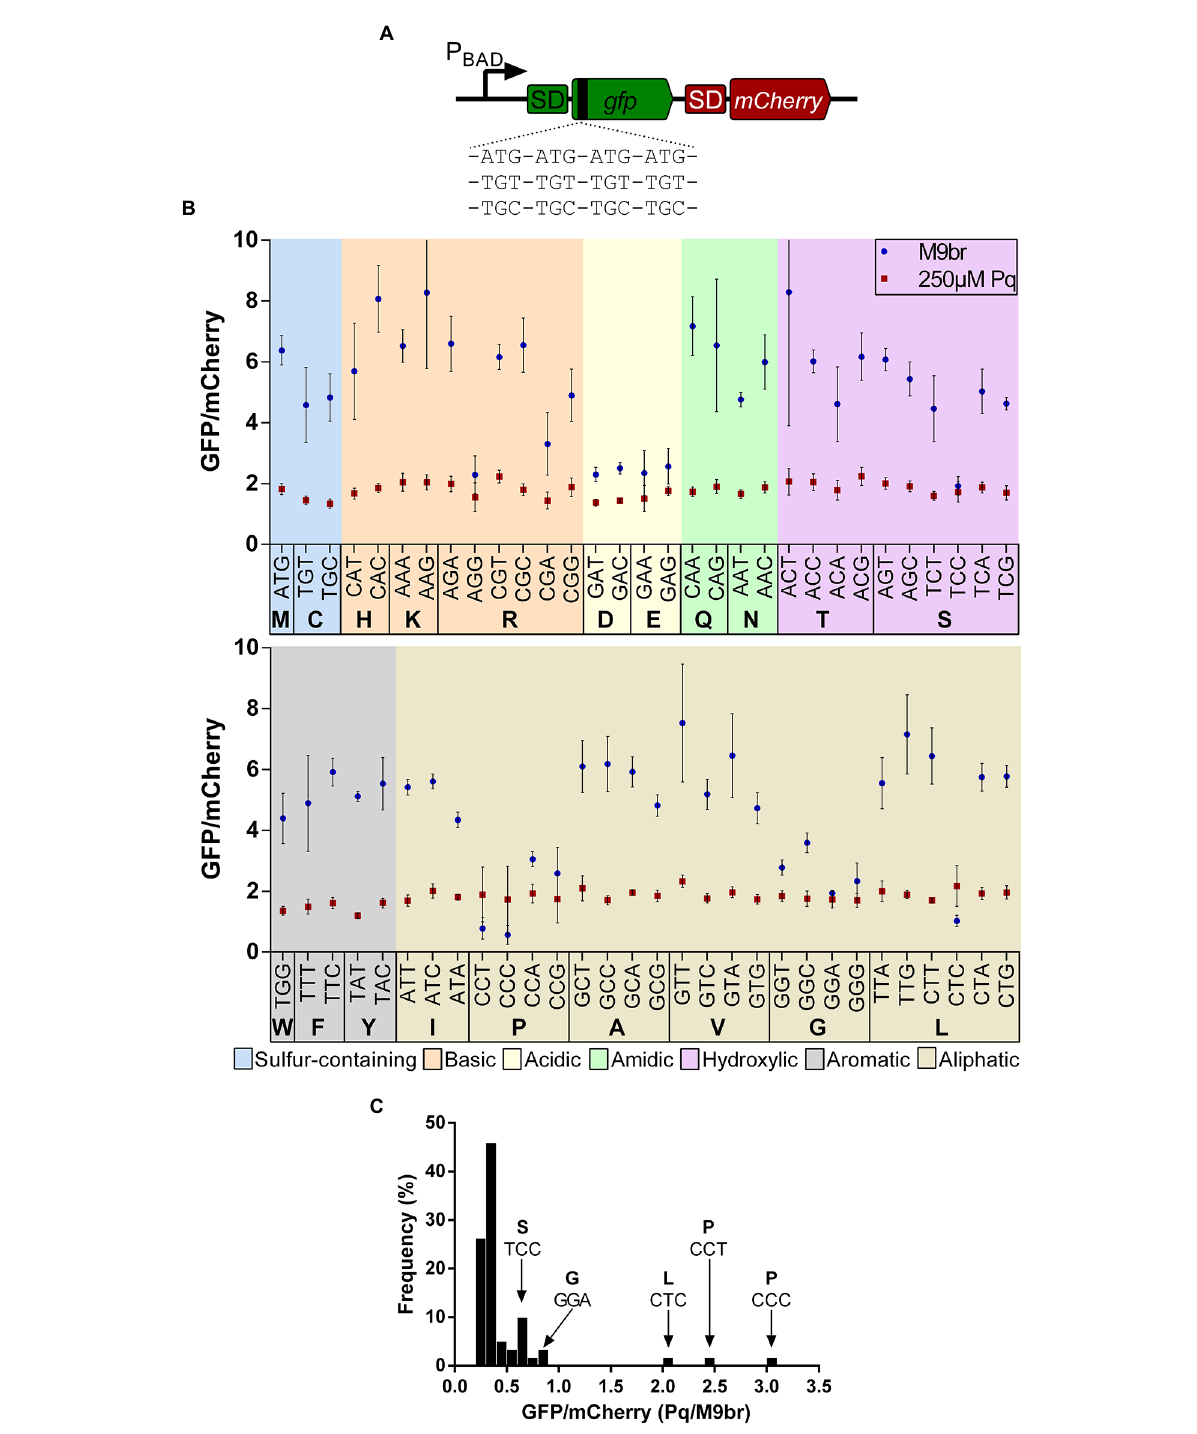
FIGURE 1 Effect of codons on the production of GFP in control and oxidative stress conditions. (A) A scheme of the reporter library used to test the effects of codons in translation under control and oxidative stress conditions. In each reporter 4 codon repetitions were inserted after the fourth codon of gfp that is cloned in transcriptional fusion upstream of the gene coding for mCherry. Each reporter plasmid was transformed into E. coli K-12 MG1655. Cells were cultured in minimal media supplemented with branched amino acids under control or oxidative stress conditions induced by 250 μ M paraquat. In both conditions expression of GFP and mCherry was induced and fluorescence of both proteins was quantified after 2 h of induction. The graph in (B) shows the average fluorescence of GFP normalized by the fluorescence of mCherry for each reporter strain under control and oxidative stress conditions. (C) The ratio between the values observed in stress and control conditions were calculated and a histogram was constructed with the number of reporters presenting each ratio using bins of 0.1